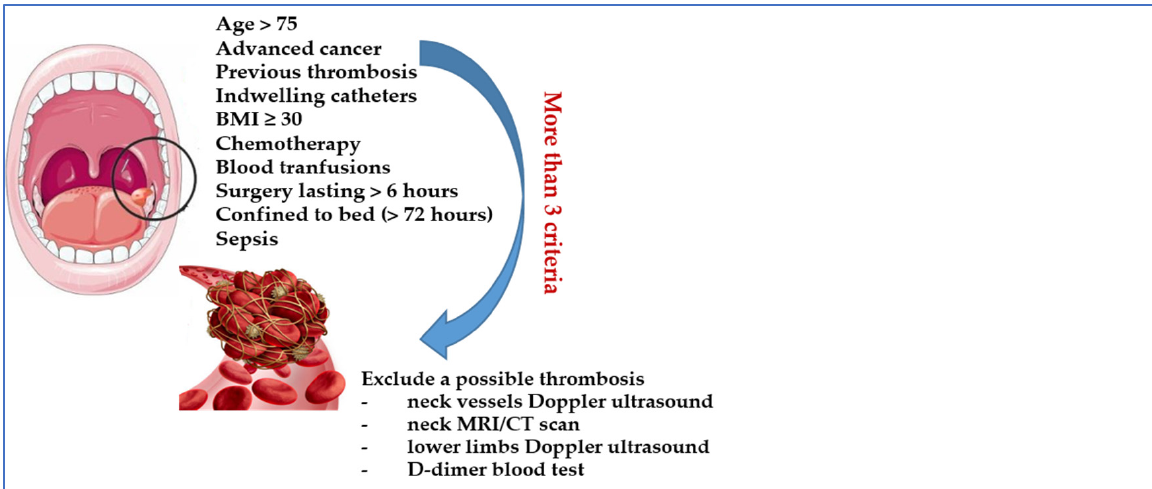
Figure 2. Suggested criteria for investigating asymptomatic thrombosis in OSCC. Table 2. Anticancer agents and thrombosis.